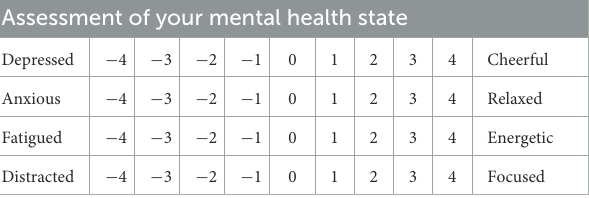
TABLE 1 Questionnaire survey content on psychological